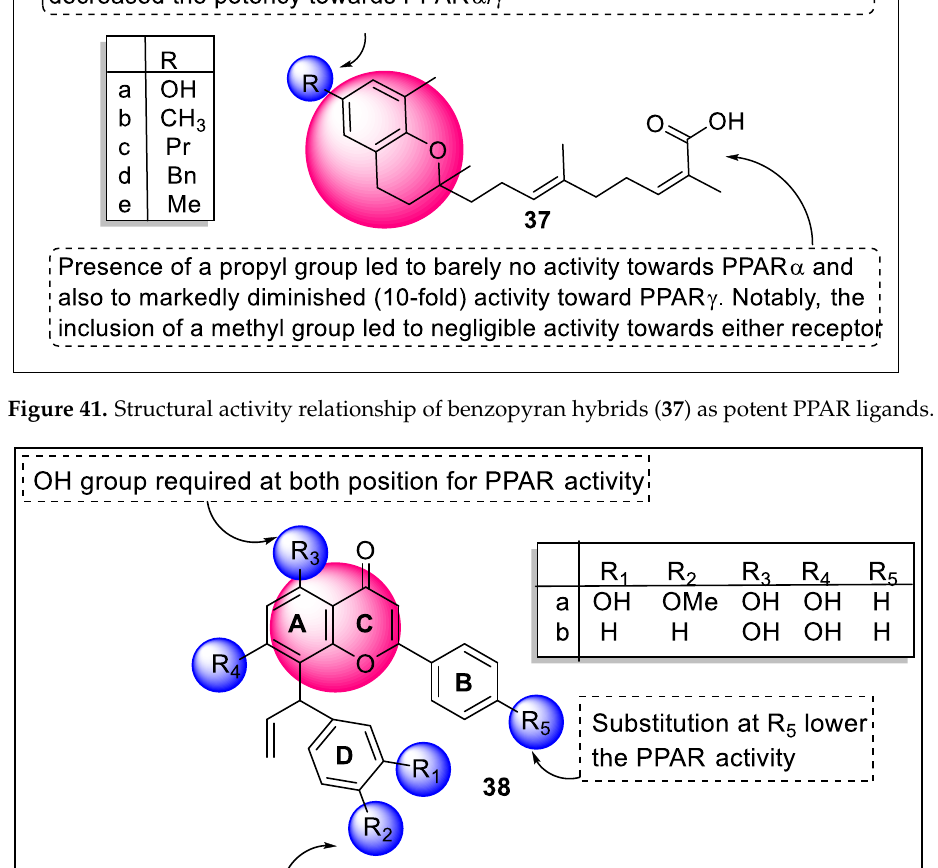
Figure 41. Structural activity relationship of benzopyran hybrids ( 37 ) as potent PPAR ligands.